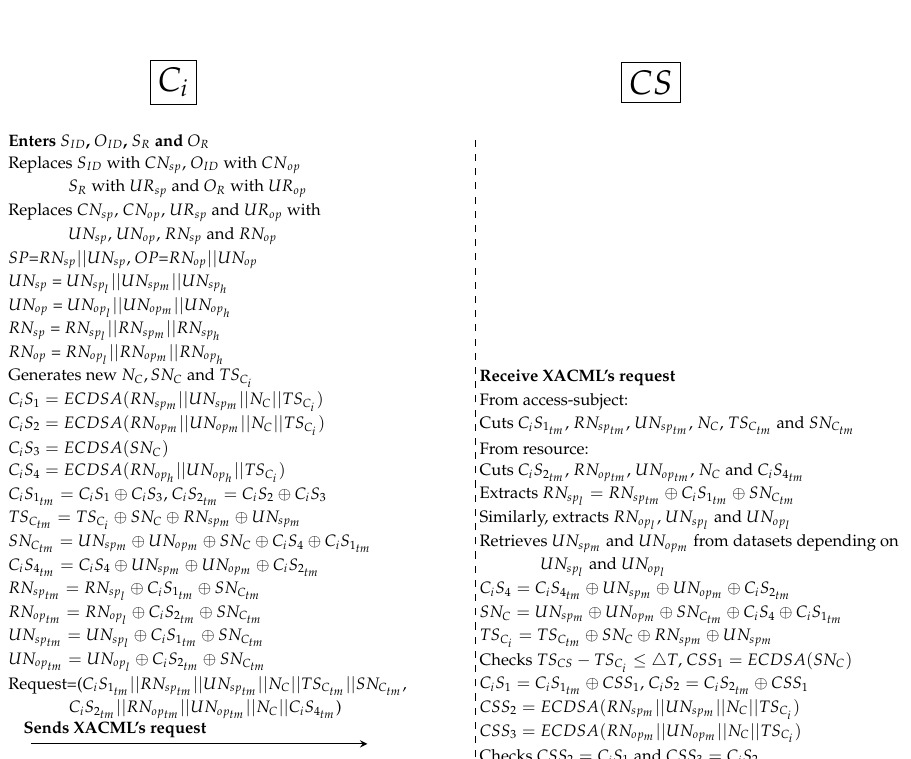
Figure 9. Protocol of PAX model between C i and CS .